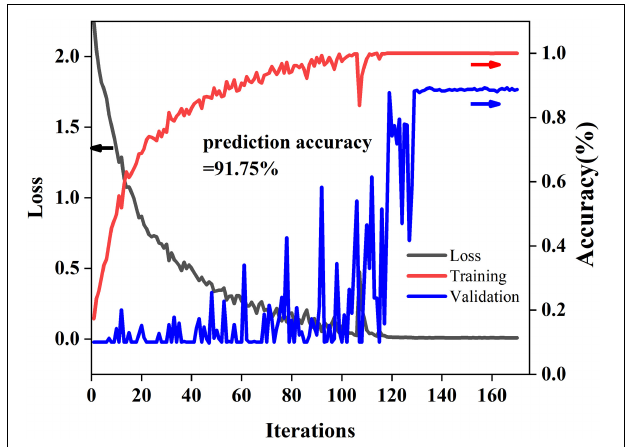
FIGURE 5 | Training and testing curves of 2D-PCSA-ResNet.